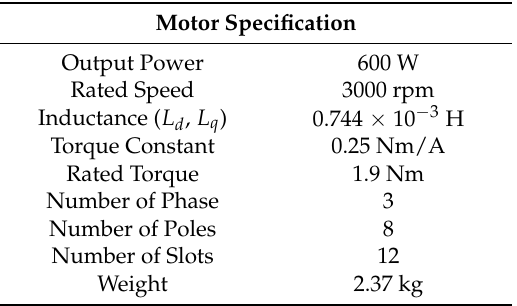
Figure 1. EMB concept for application to the pneumatic brake caliper of HEMU-430X. Table 1. SPMSM Specification.